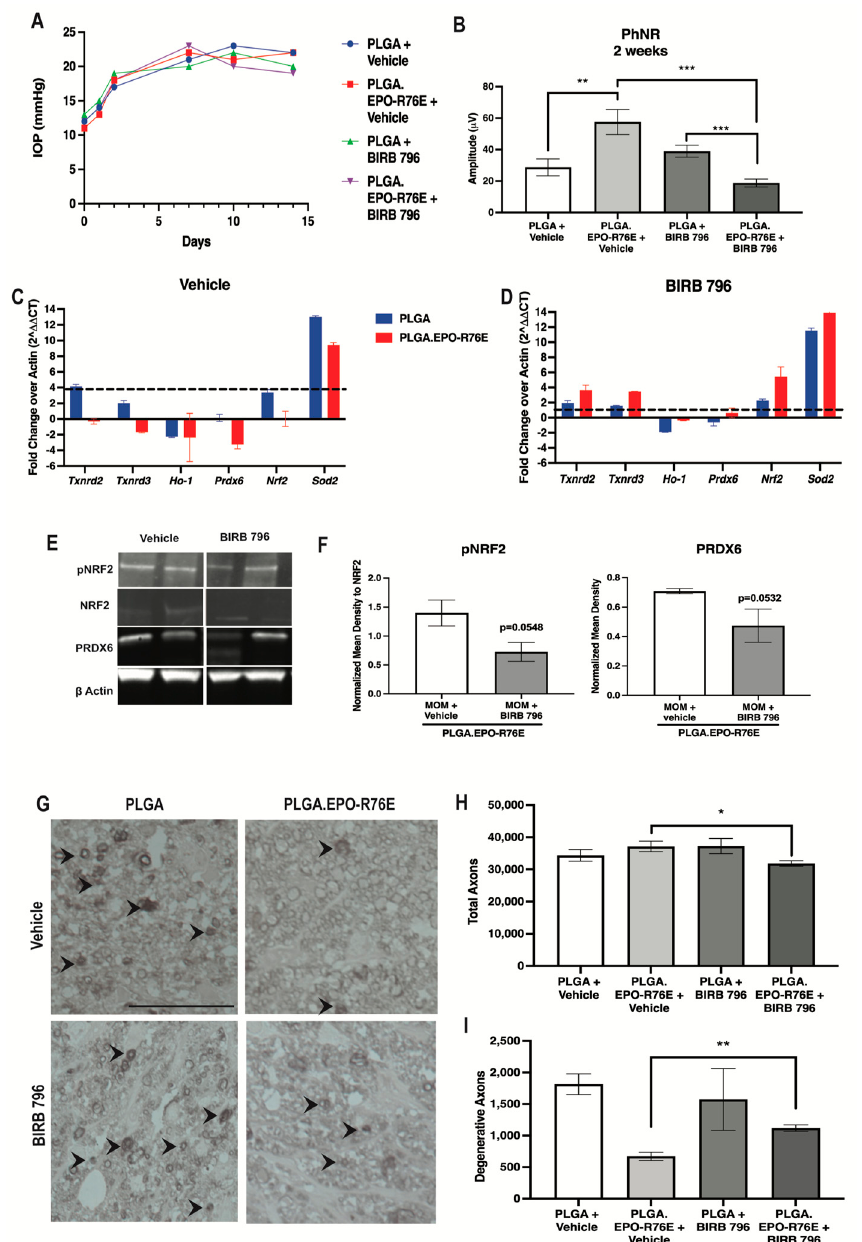
Figure 5. ( A ) IOP levels over time in mice intravitreally injected with PLGA or PLGA.EPO-R76E and then 1 week later, injected with either vehicle or BIRB 796. ( B ) Quantification of PhNR amplitude of the ERG at 2 post-IOP elevation for all groups, ** p = 0.01, *** p < 0.001. ( C , D ) Quantification of antioxidant gene transcription shown as fold change over actin at 2 weeks post-IOP elevation in mice injected with vehicle or BIRB 796, respectively. ( E ) Representative Western blots for pNRF2, NRF2, PRDX6, and β -actin. pNRF2 was normalized to total NRF2 and PRDX6 was normalized to β -actin. ( F ) Quantification of pNRF2 and PRDX6 appropriately normalized as stated in ( E ), * p < 0.05, ** p = 0.01. ( G ) Representative micrographs of optic nerves at 2 and 5 weeks post-IOP elevation for all groups. ( H , I ) Quantification of total and degenerative axons, respectively, in optic nerves at 2 weeks post-IOP elevation for all groups, * p < 0.05, ** p = 0.01. Since we showed PLGA.EPO-R76E’s upregulation of ARE-driven transcripts follow- ing IOP elevation, we examined if inhibition of MAPK would affect PLGA.EPO-R76E’s